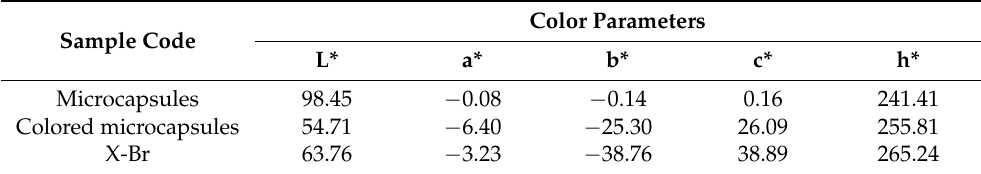
Table 5. Color parameters of colored